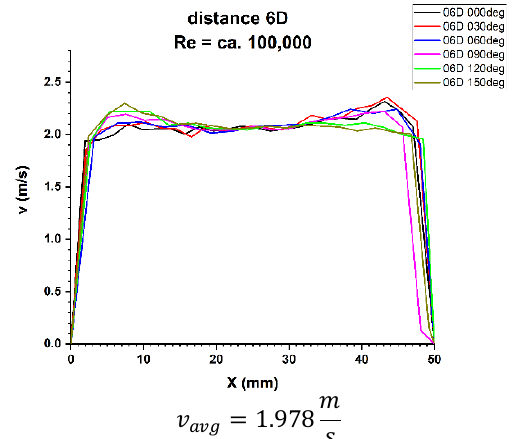
Figure 16. Velocity profiles at a distance 6D from the disturbance with marked cross-sections for Re ≅ 100,000-The LDA measurement taken in the ultrasound wave path.